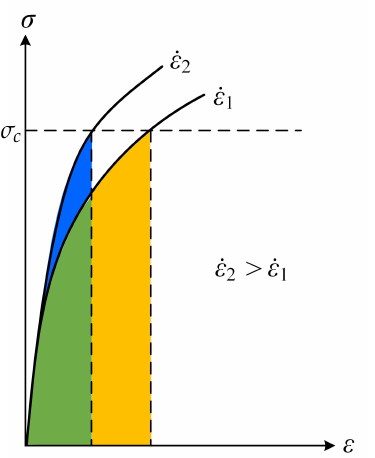
Figure 5. Qualitative explanation of strain rate dependence of a brittle